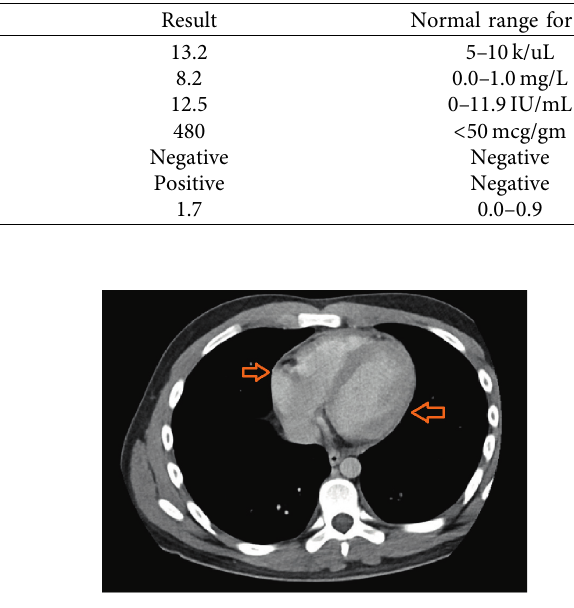
Table 1: Laboratory results of our patient upon presentation and diagnosis.